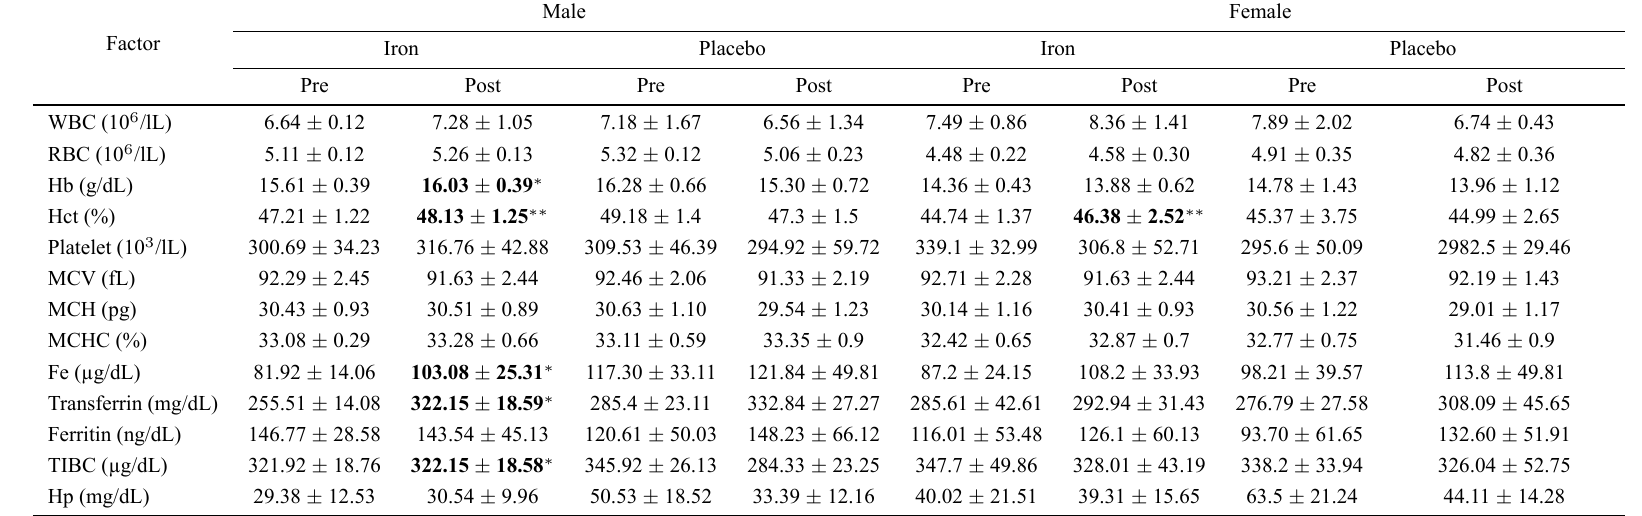
Table 3. Complete blood cell types, iron and haptoglobin levels in blood.